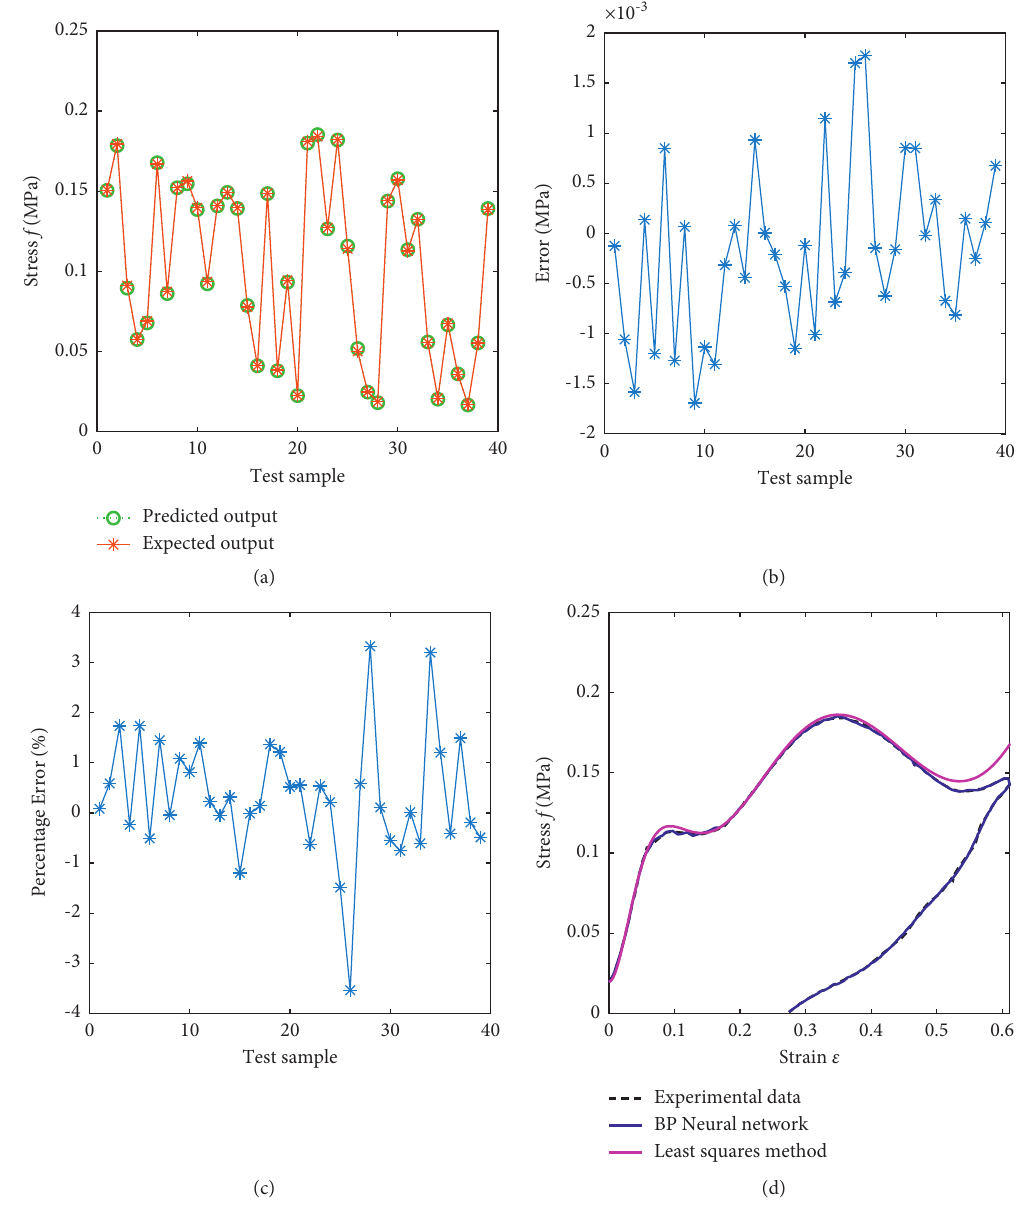
Figure 4: Prediction result of corrugated paperboard. (a) and (b) show the error between expected and predicted output; (c) shows the ratio of error to expected output; (d) shows the result of data fitting using the trained BP